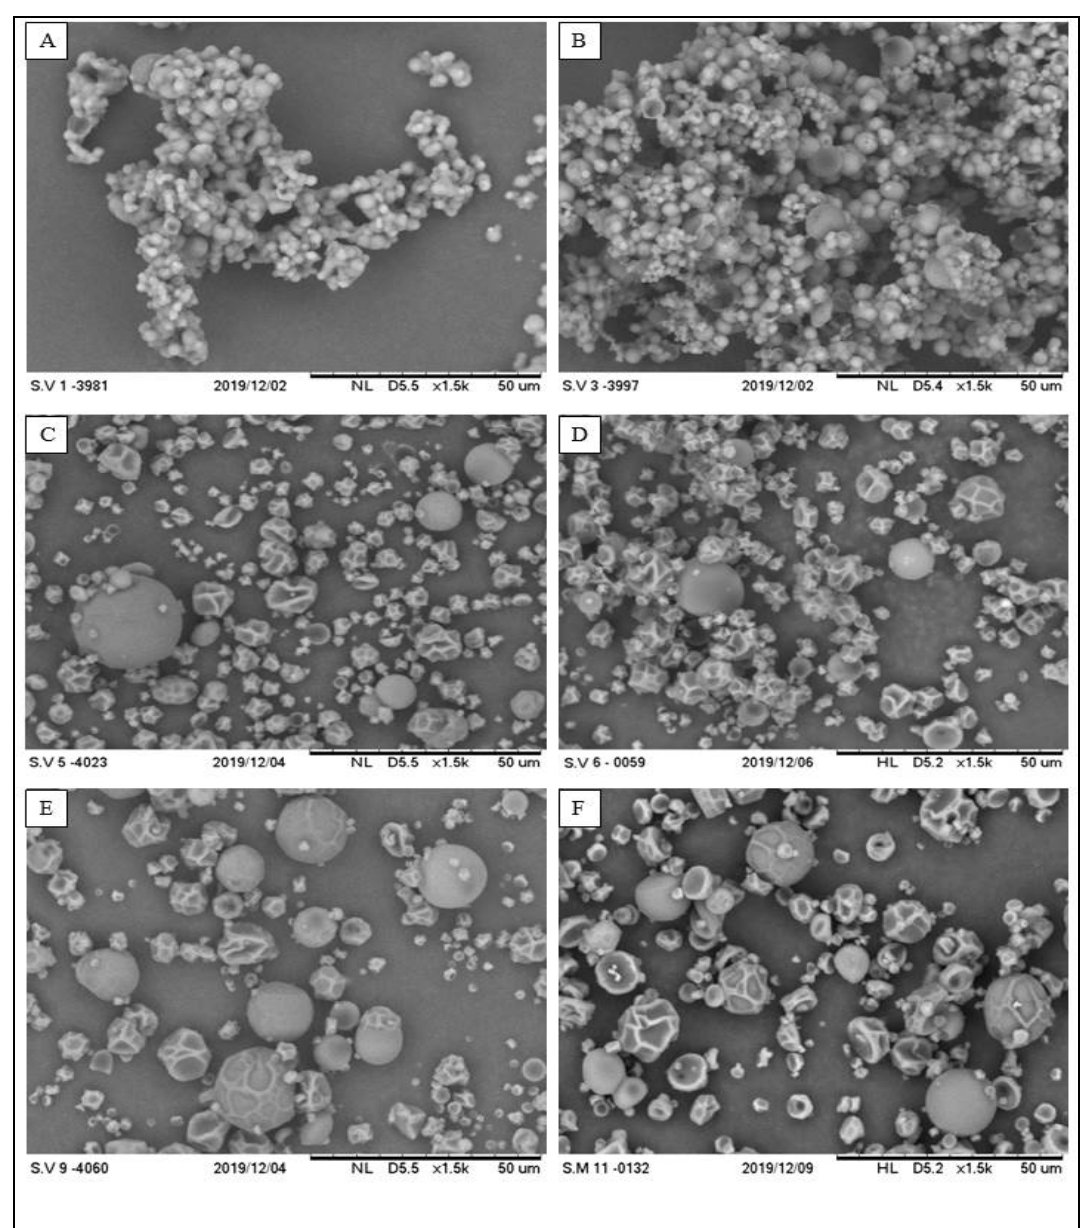
Figure 2. Micrographs of particles of ripe papaya seed extracts sprayed at 130 and 150 °C. In this figure: ( A ) sample with 0% maltodextrin and dried at 130 °C; ( B ) sample with 0% maltodextrin and figure: ( A ) sample with 0% maltodextrin and dried at 130 ◦ C; ( B ) sample with 0% maltodextrin dried at 150 °C; ( C ): sample with 15% maltodextrin and dried at 130 °C; ( D ) sample with 15% and dried at 150 ◦ C; ( C ): sample with 15% maltodextrin and dried at 130 ◦ C; ( D ) sample with 15% maltodextrin dried at 150 °C; ( E ) sample with 30% maltodextrin increased and dried at 130 °C; ( F ) maltodextrin dried at 150 ◦ C; ( E ) sample with 30% maltodextrin increased and dried at 130 ◦ C; sample with 30% maltodextrin and dried at 150 °C. ( F ) sample with 30% maltodextrin and dried at 150 ◦